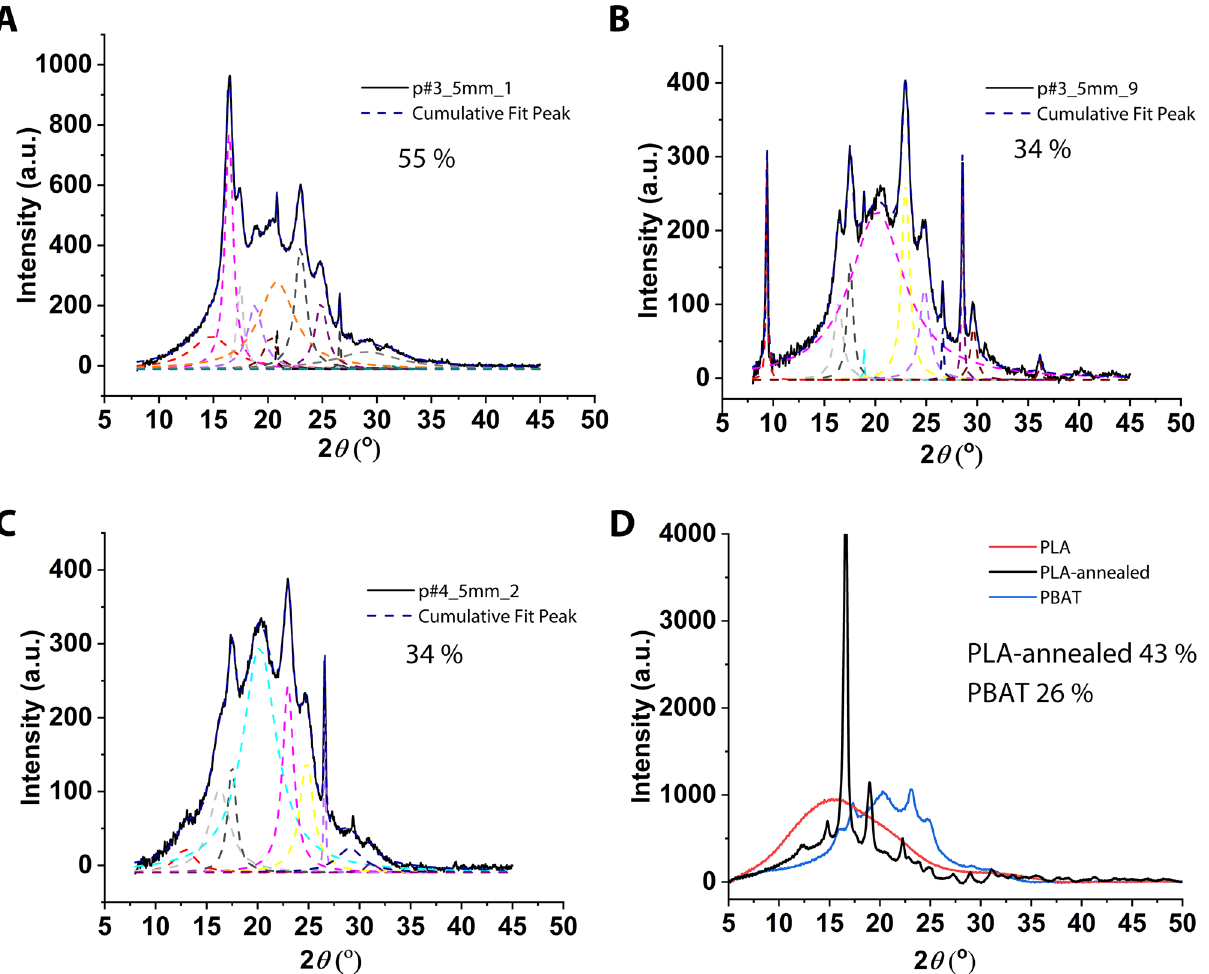
Figure 5. WAXS curves with Lorenz fitting for ( A ) fragment p#3_5mm_1, ( B ) fragment p#3_5mm_9, and ( C ) fragment p#4_5mm_2. ( D ) WAXS curves for foils produced from the PBAT and PLA reference materials; the percent values indicate the crystallinity. The dash lines are the fitting peak curves for the XRD spectrum. Crystallinity can be obtained by dividing the integration area of the fitted peaks by the integration area of the entire spectrum. Fragments were coded as follows: p or f for pre-compost or finished compost, followed by the plant number (#1 to #4), an indication of the size fraction (> 5 mm or 1–5 mm) in which the fragment was found, and finally, the fragment